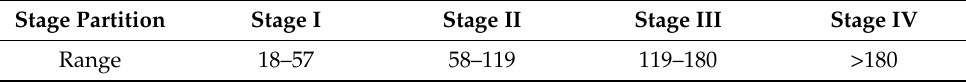
Table 4. Decision value range for each pathological stage of NSCLC.